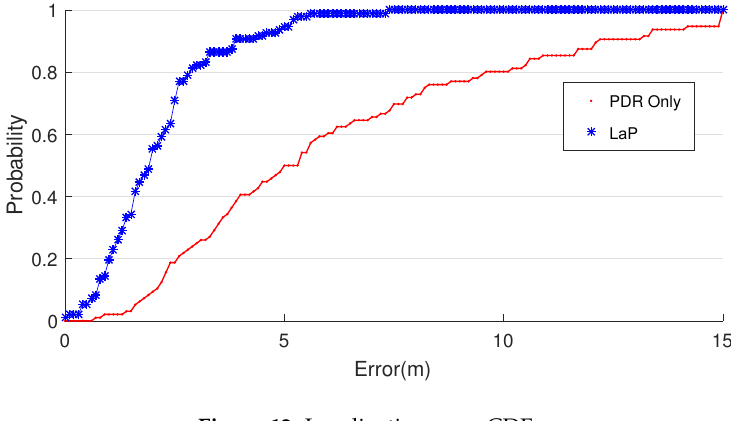
Figure 12. Localization error CDF.